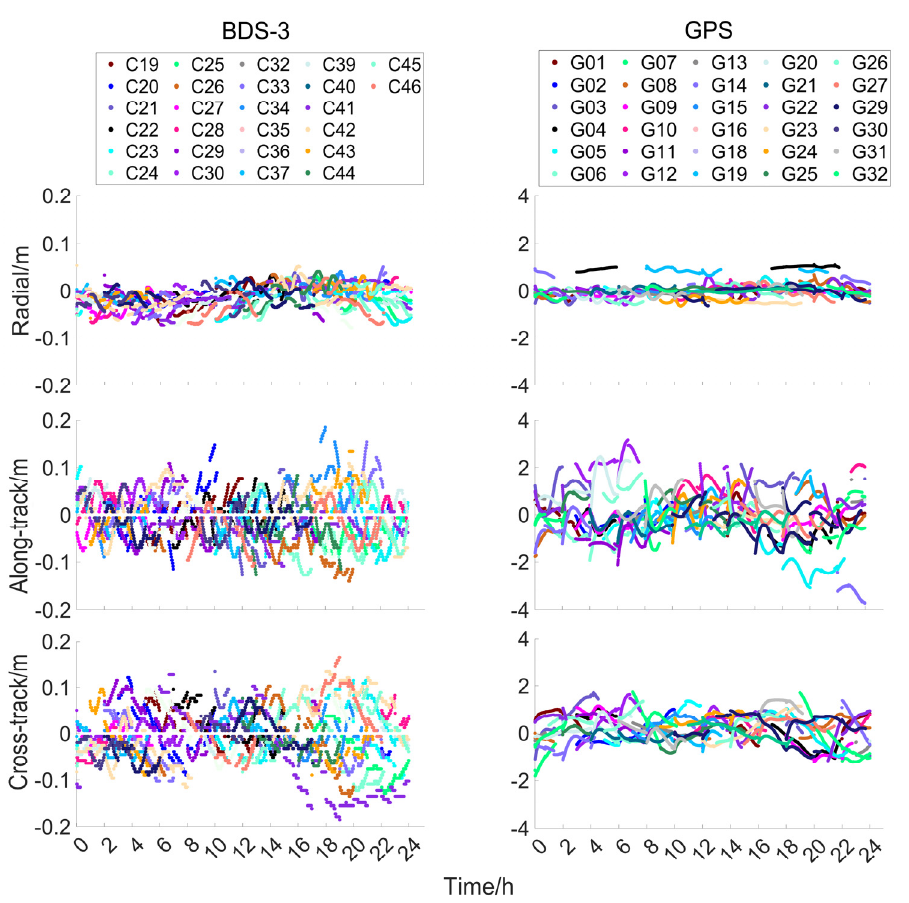
Figure 2. Time series of the orbit corrections of the BDS-3 and the GPS satellites in the radial, along-, and cross-track directions on DOY 192 in 2022.